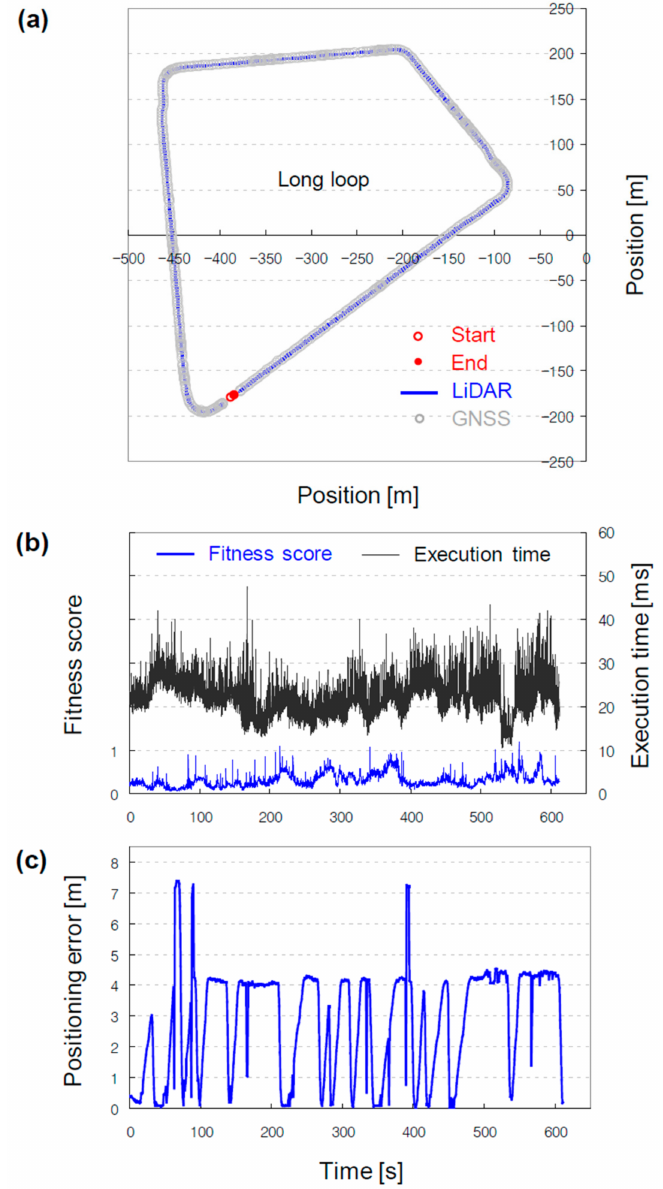
Figure 8. Validation results of the generated pointcloud map. ( a ) Positions of the vehicle measured by the LiDAR and GNSS localizers. ( b ) Fitness score and execution time, estimates from the LiDAR localizer, which are used as key metrics for localization based on the generated pointcloud map. ( c ) Positioning error, a measurement obtained through comparison to the GNSS